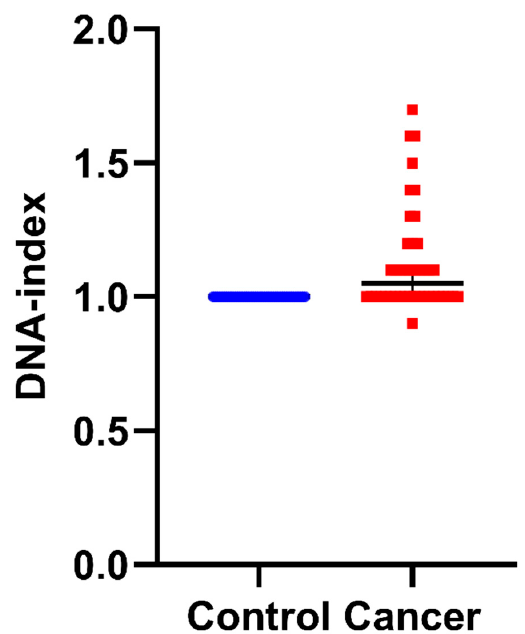
Figure 2. DNA index as an indicator of aneuploidy in normal control samples versus tumor cells: DNA index values were quantified following iFC analysis, as a quotient of the geometric mean of G0/G1 in normal (based on analysis of PBMCs) vs. cancer cells in individual patient samples. DNA index scores of individual samples are presented as blue or red dots, for normal and cancer tissue, respectively. A DNA index of ≠ 1 is a distinct hallmark of cancer cells. The median DNA index is shown as a horizontal line in each group.